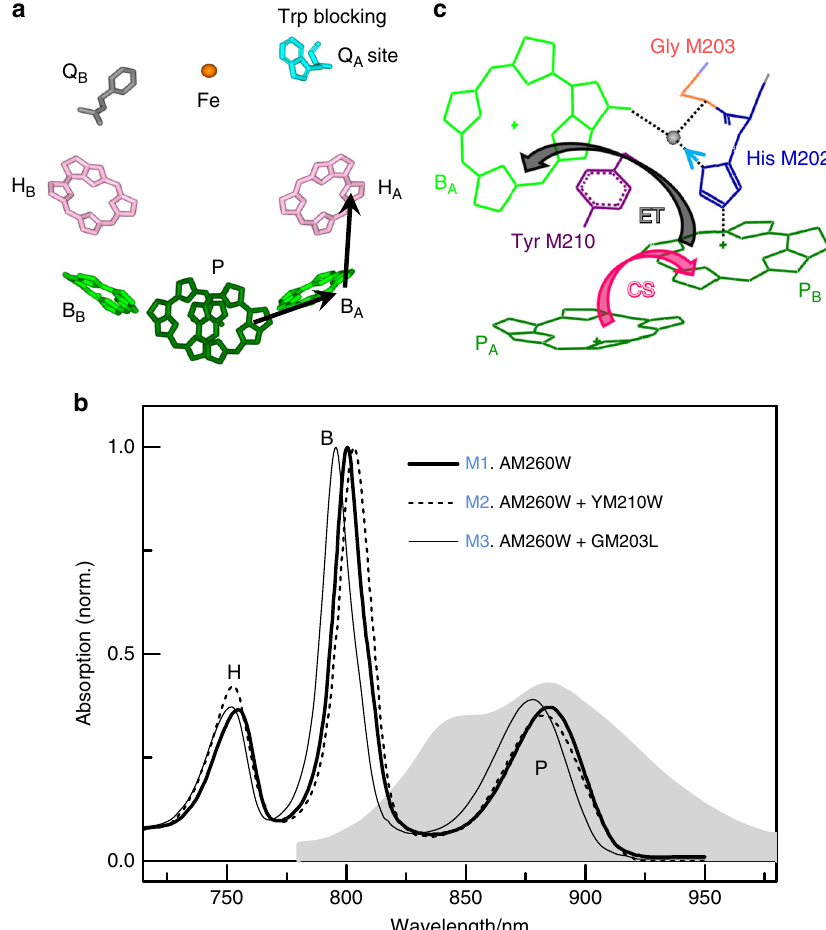
Fig. 1 Cofactor structure and absorption spectra of reaction centers (RCs). a Arrangement of cofactors and the electron transfer (ET) pathway in M1 , which lacks a Q A acceptor due to an alanine to tryptophan replacement (the crystal structure is from PDB record 1QOV 20 ). b Normalized absorption spectra of M1 (solid line), M2 (dashed line), and M3 (light solid line) at 77 K overlaid with the laser spectrum (gray shaded area). c Scheme of charge separation (pink arrow) and ET (black arrow) with mutation site for M2 (Tyr M210, purple) and M3 (Gly M203, red). A water molecule (gray ball) links P B and B A via a hydrogen-bond interaction involving the former ’ s axial histidine M202 (dotted